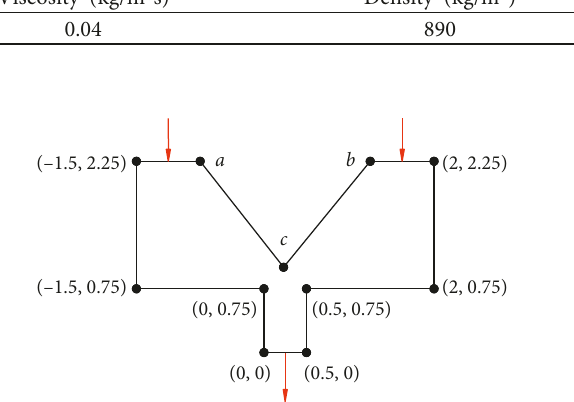
Figure 5: Structural sketch of 60 ° conical valve core.